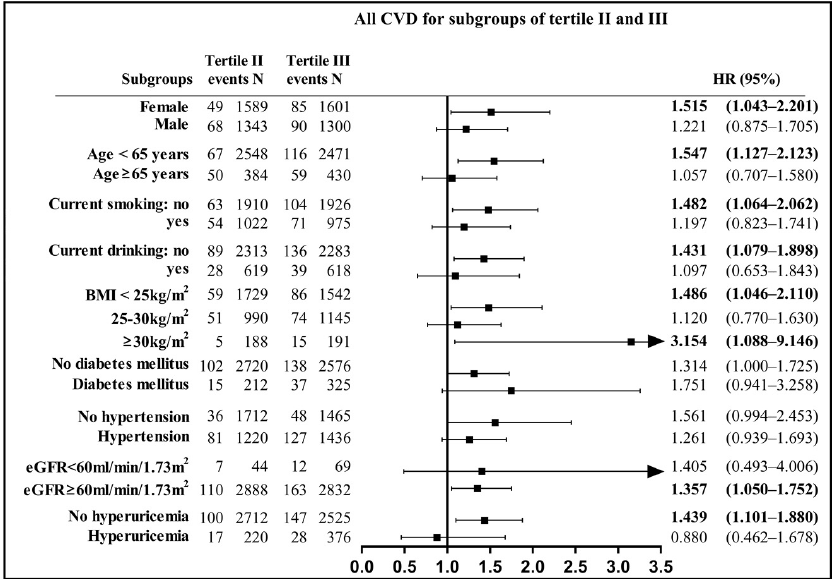
Figure 2. Remnant cholesterol (Tertile II and Tertile III) in relation to combined cardiovascular disease (CVD) for different subgroups. Model adjusted for age, sex, ethnicity, body mass index, smoking status, drinking status, hypertension, diabetes mellitus, estimated glomerular filtration rate, hyperuricemia, and continuous triglyceride. BMI: body mass index; CI: confidence interval; CVD: cardiovascular disease; eGFR: estimated glomerular filtration rate; HR: hazard ratio; RC: remnant cholesterol.